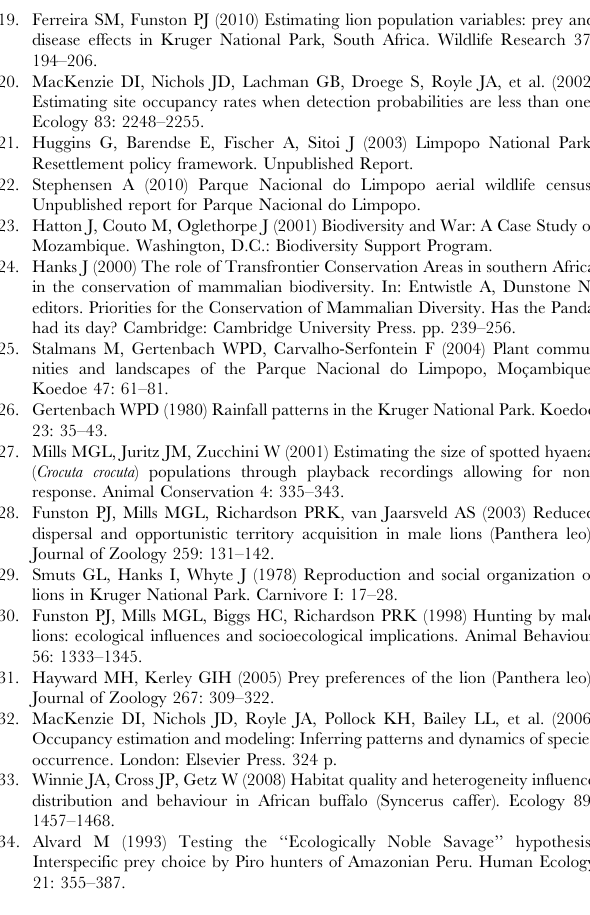
poaching. Table S4. Summary of model selection procedure for factors influencing buffalo site use ( Y ) across 82 sites in the Limpopo National Park, Mozambique. Table S5. Summary of model selection procedure for factors influencing bushmeat poaching site use ( Y ) across 82 sites in the Limpopo National Park,